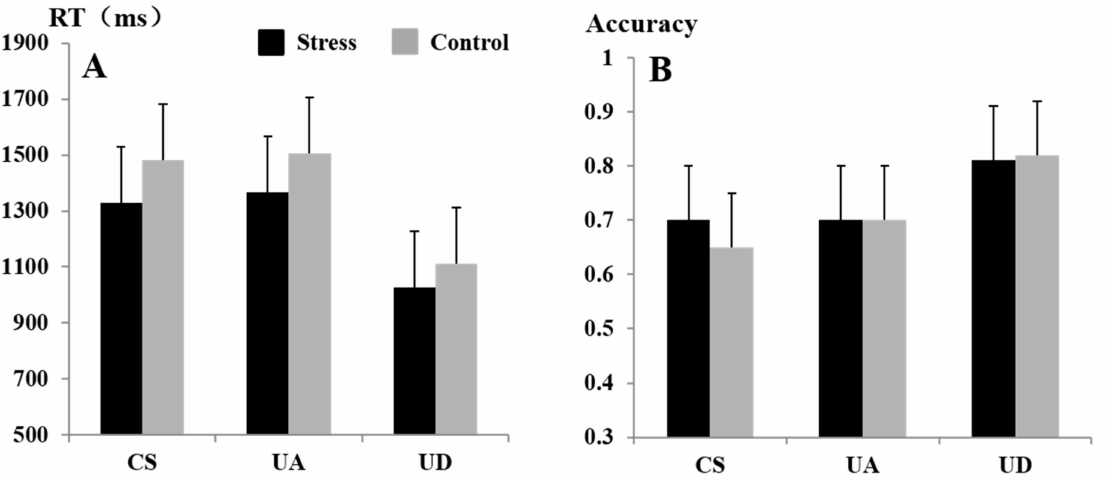
Figure 3. RT ( A ) and accuracy ( B ) at different stress levels and speed types. The error bars indicate the SEM .